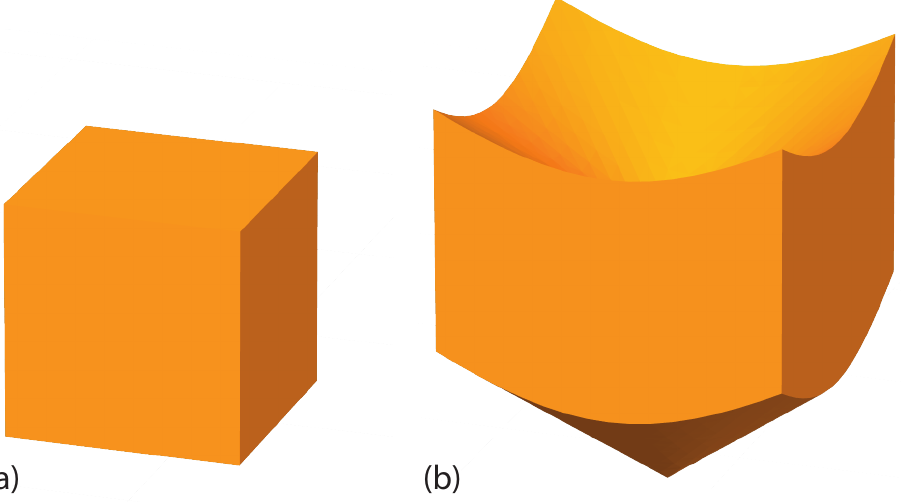
Figure 4. Visualization of the Transformation T with a cube. ( a ) shows the original cube, whereas ( b ) shows the transformed geometry in the same